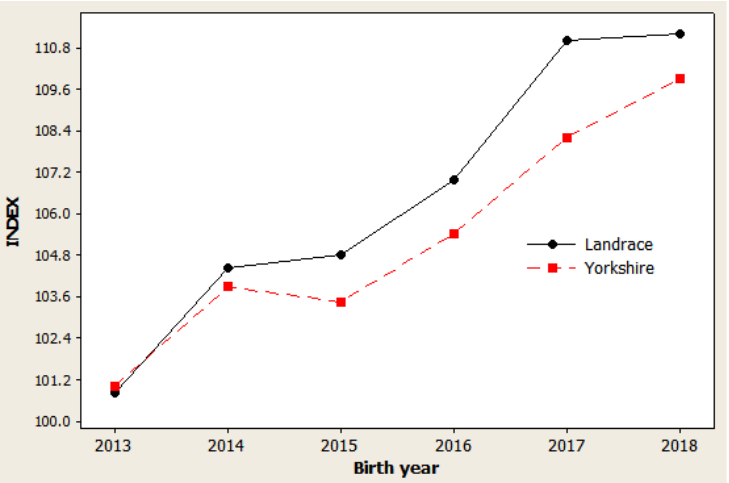
Figure 4. Genetic trend of sow productivity index in Danish Landrace and Yorkshire pigs by year of birth. Regression coefficients were 2.11 index point/yr (p = 0.001) for Landrace and 1.70 index point/yr (p = 0.001) for Yorkshire pigs.